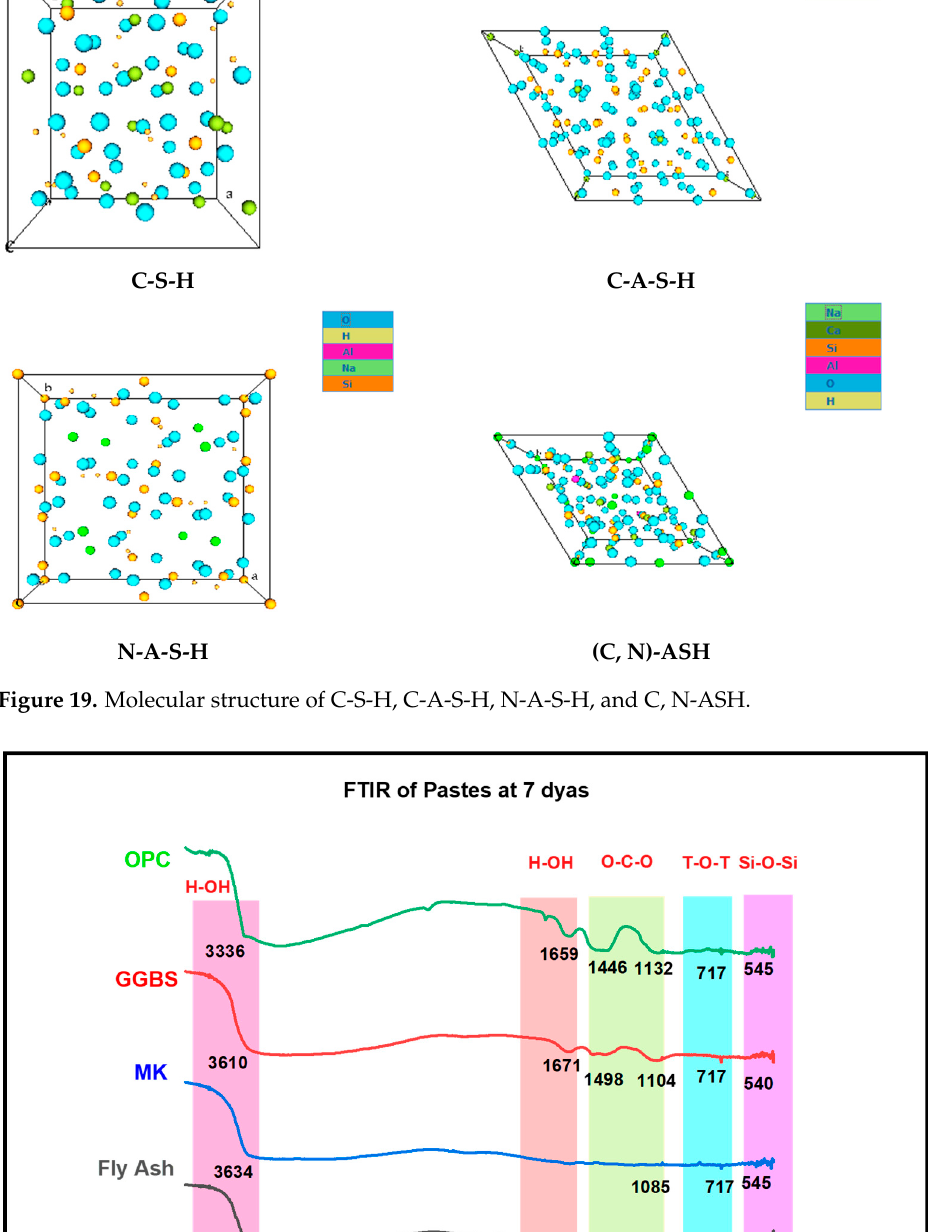
Figure 18. XRD of OPC paste at 7 days of ambient curing.